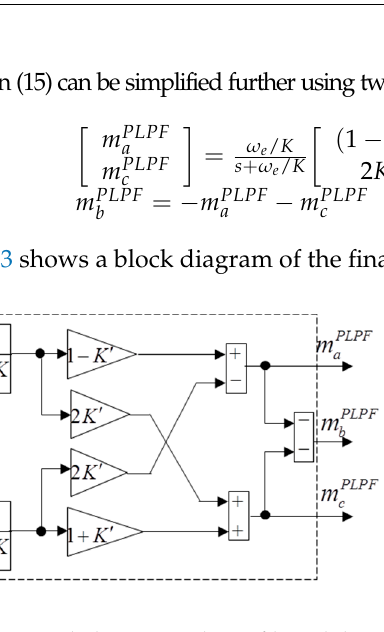
Figure 5. The filtering performance of the LPF and two PLPFs. The conventional PLPF and extended PLPF are identical from the standpoints of filter performance and compensation performance, as shown in the above results. How- ever, from a signal flow perspective, there is a difference between the two PLPFs. As shown in Figure 6a, the conventional PLPF requires an inverse reference frame transformation in order to obtain filtered three-phase variables. Therefore, the signal flows are complicated and mix both three-phase variables and variables in the stationary reference frame when adding an algorithm that directly requires three-phase variables.